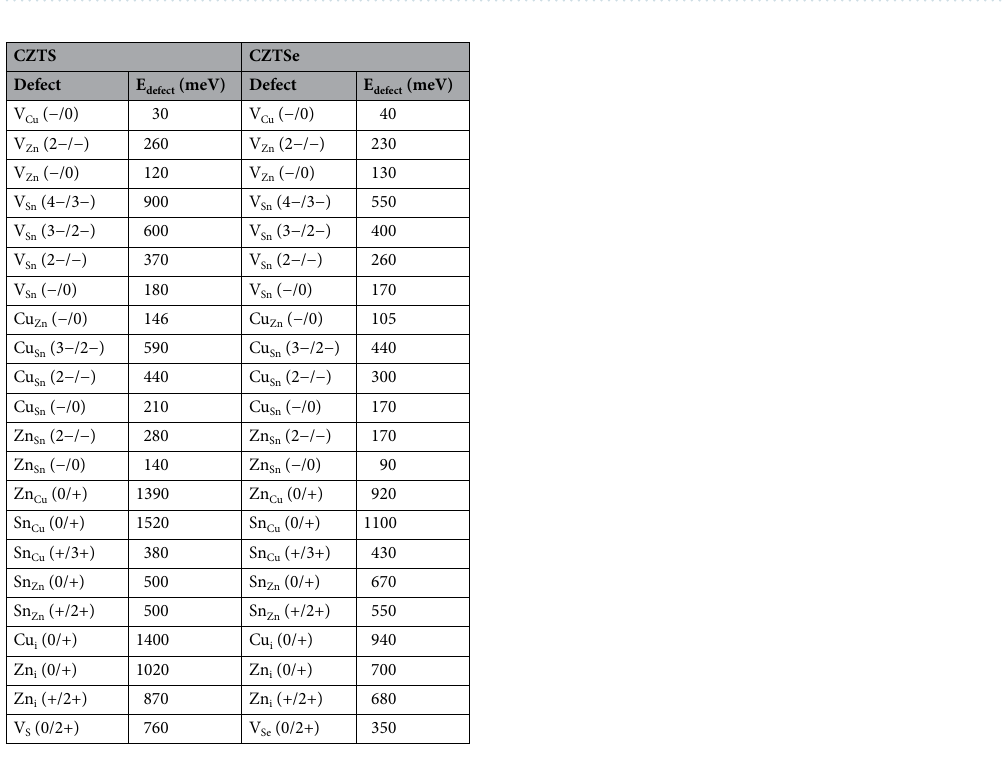
Table 3. The energy level position of acceptor and donor lattice defects (inside the bandgap with respect to the VBM positions) for CZTS (left column), and CZTSe (right column) layers based on the Density Functional Theory (DFT) calculations 36